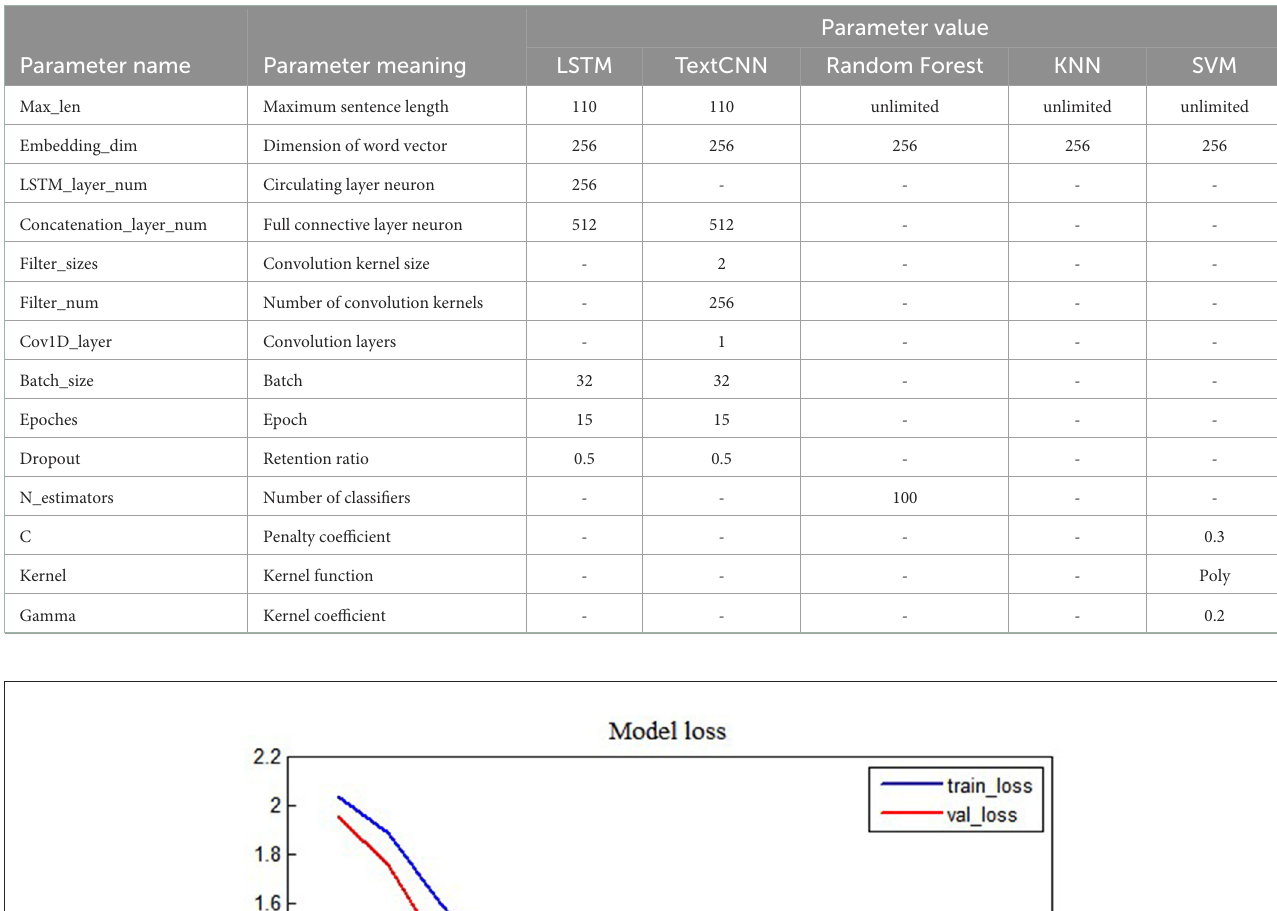
TABLE 2 The related parameter settings.